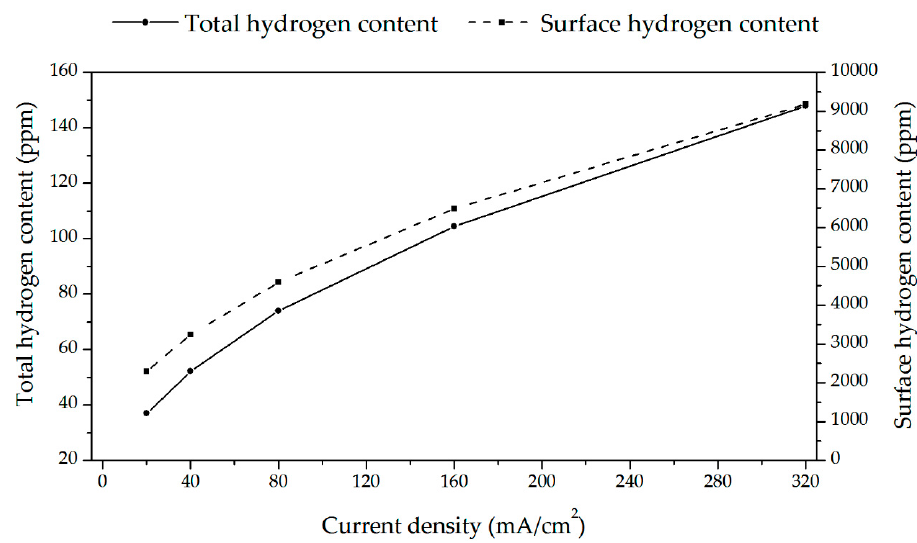
Figure 16. Recalculation of total hydrogen content to surface hydrogen content at different cathodic current densities.